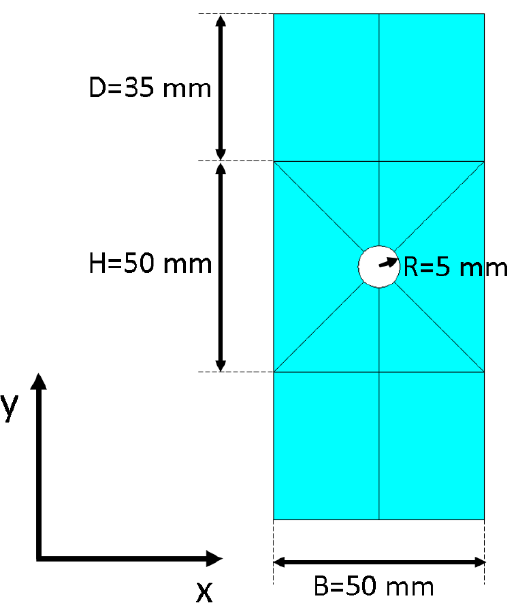
Figure 2. Geometry of the drilled plate.